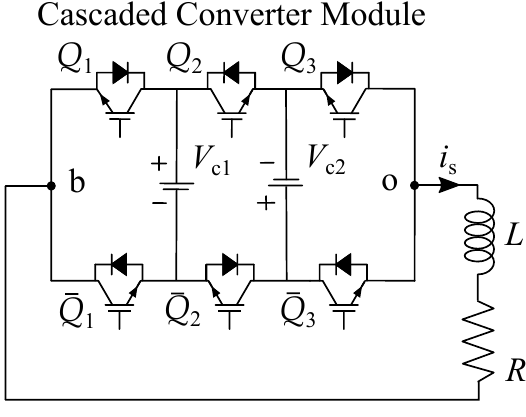
Figure 5. Five-level converter